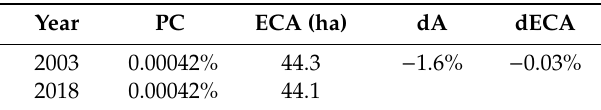
Figure 9. Common toad habitat networks composed of habitat patches and interpatch least-cost pathways in 2003 and 2018. pathways in 2003 and 2018. Table 6. Values of the PC index, ECA and percentage changes in total habitat area (dA) and ECA (dECA) for the 2003 and 2018 common toad habitat